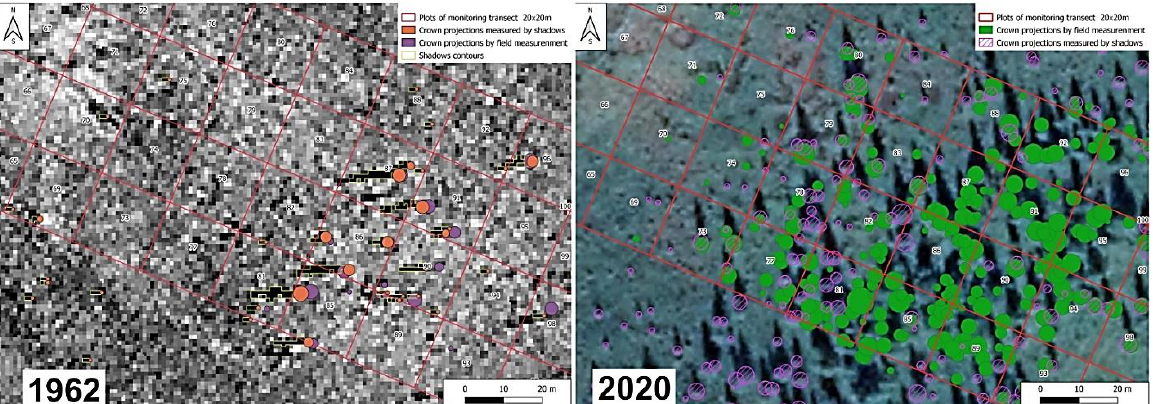
Figure 3. Tree shadows and crown projections built using aerial photos from 1962 ( left ), satellite images from 2020 ( right ) and field data measurements from 1960 and 2020.